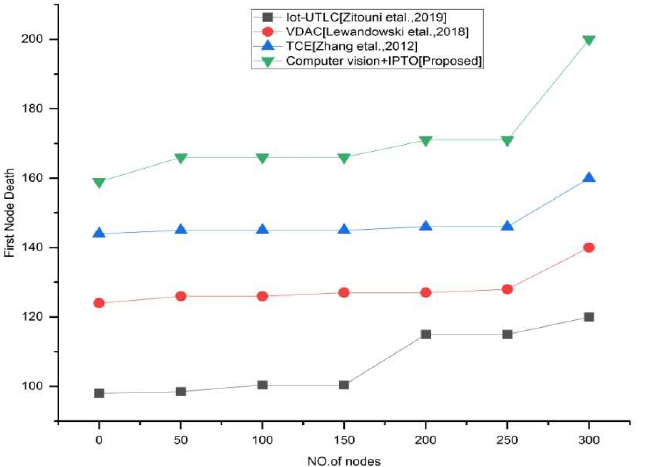
Figure 7. First node death vs. number of nodes for the existing and proposed method.